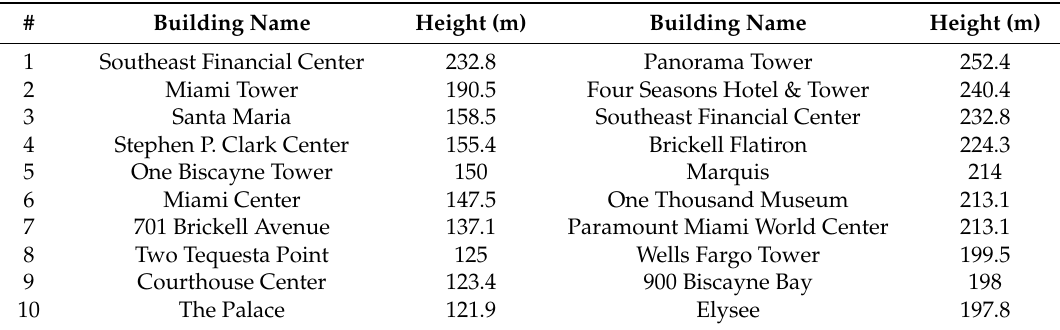
Figure 11. Miami in 2000 and 2020. Table 21. Miami’s 10 tallest skyscrapers in 2000 and 2020.